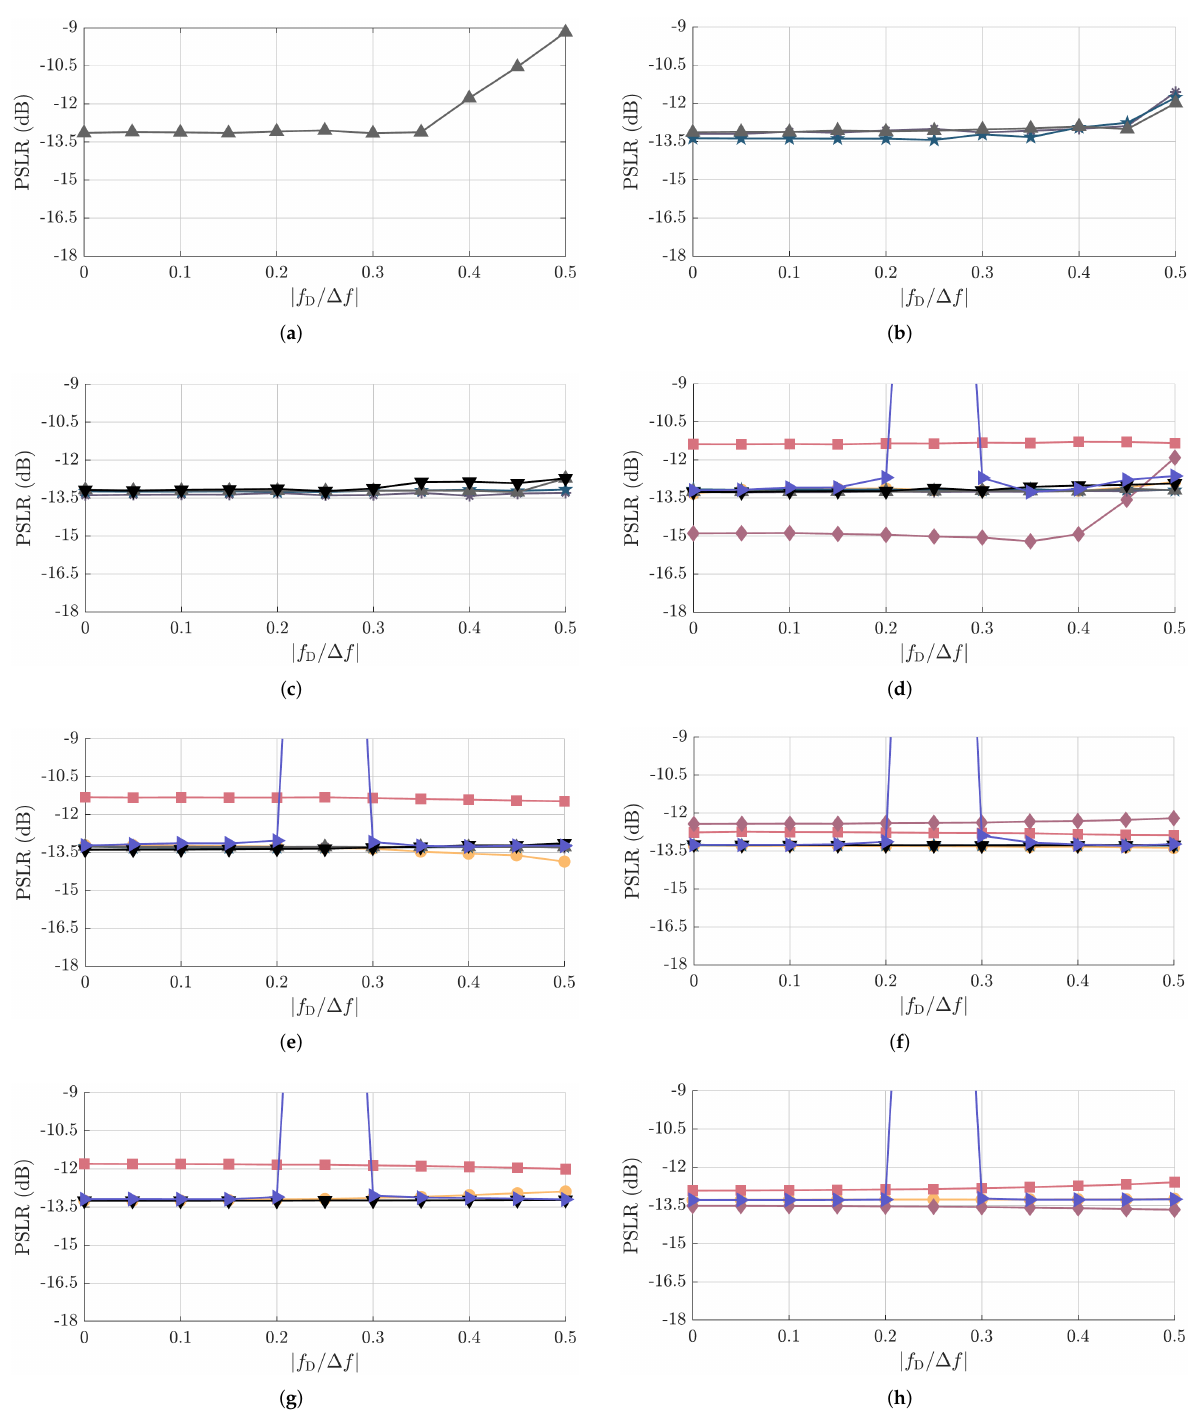
Figure 10. Measured PSLR as a function of f D / ∆ f for the considered PRBSs with approxi- mate PACF usable length of ( a ) N PRBS,usable = 32, ( b ) N PRBS,usable = 64, ( c ) N PRBS,usable = 128, ( d ) N PRBS,usable = 256, ( e ) N PRBS,usable = 512, ( f ) N PRBS,usable = 1024, ( g ) N PRBS,usable = 2048, and ( h ) N PRBS,usable = 4096. The considered PRBSs are m-sequence ( ), Gold sequence ( (cid:4) ), Kasami (cid:32) sequence ( (cid:7) ), APAS ( (cid:72) ), ZCZ sequence ( (cid:78) ), Golay A ( ), Golay B ( (cid:70) ), and the combination of (cid:66) complementary sequences Golay A and B ( (cid:73) ). The correspondence between their N PRBS,usable and N PRBS values is listed in Table